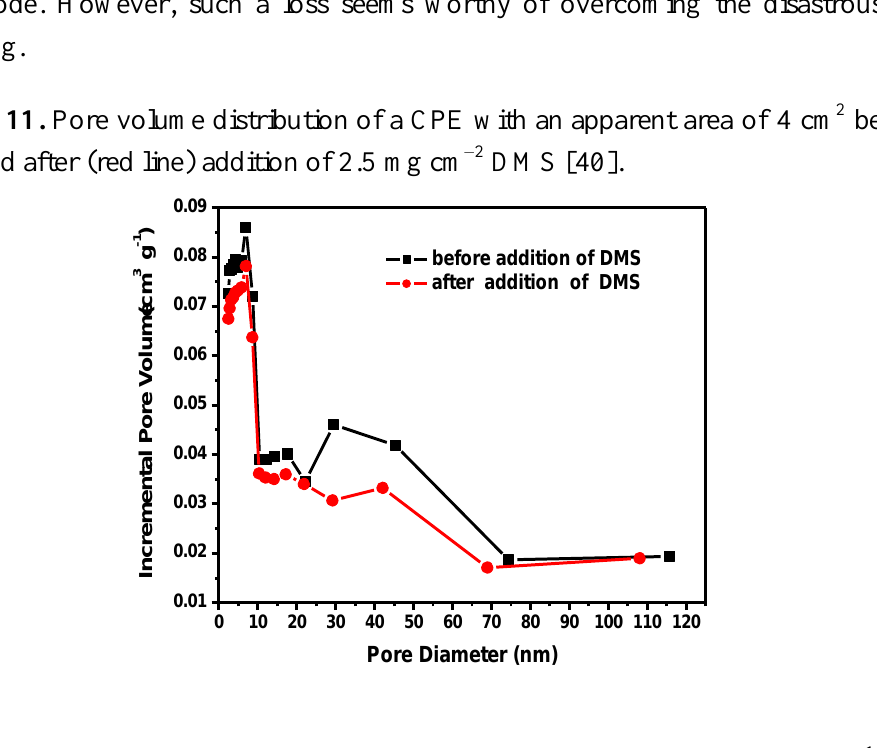
Figure 12. Comparison of CO stripping voltammograms acquired at 10 mV s –1 plotted for CPE and AFE in 0.5 mol L –1 H SO solution under argon atmosphere at room temperature. 2 4 Scan rate: 10 mV s −1 , the Pt loading for CPE and AFE is 1.5 mg cm – 2